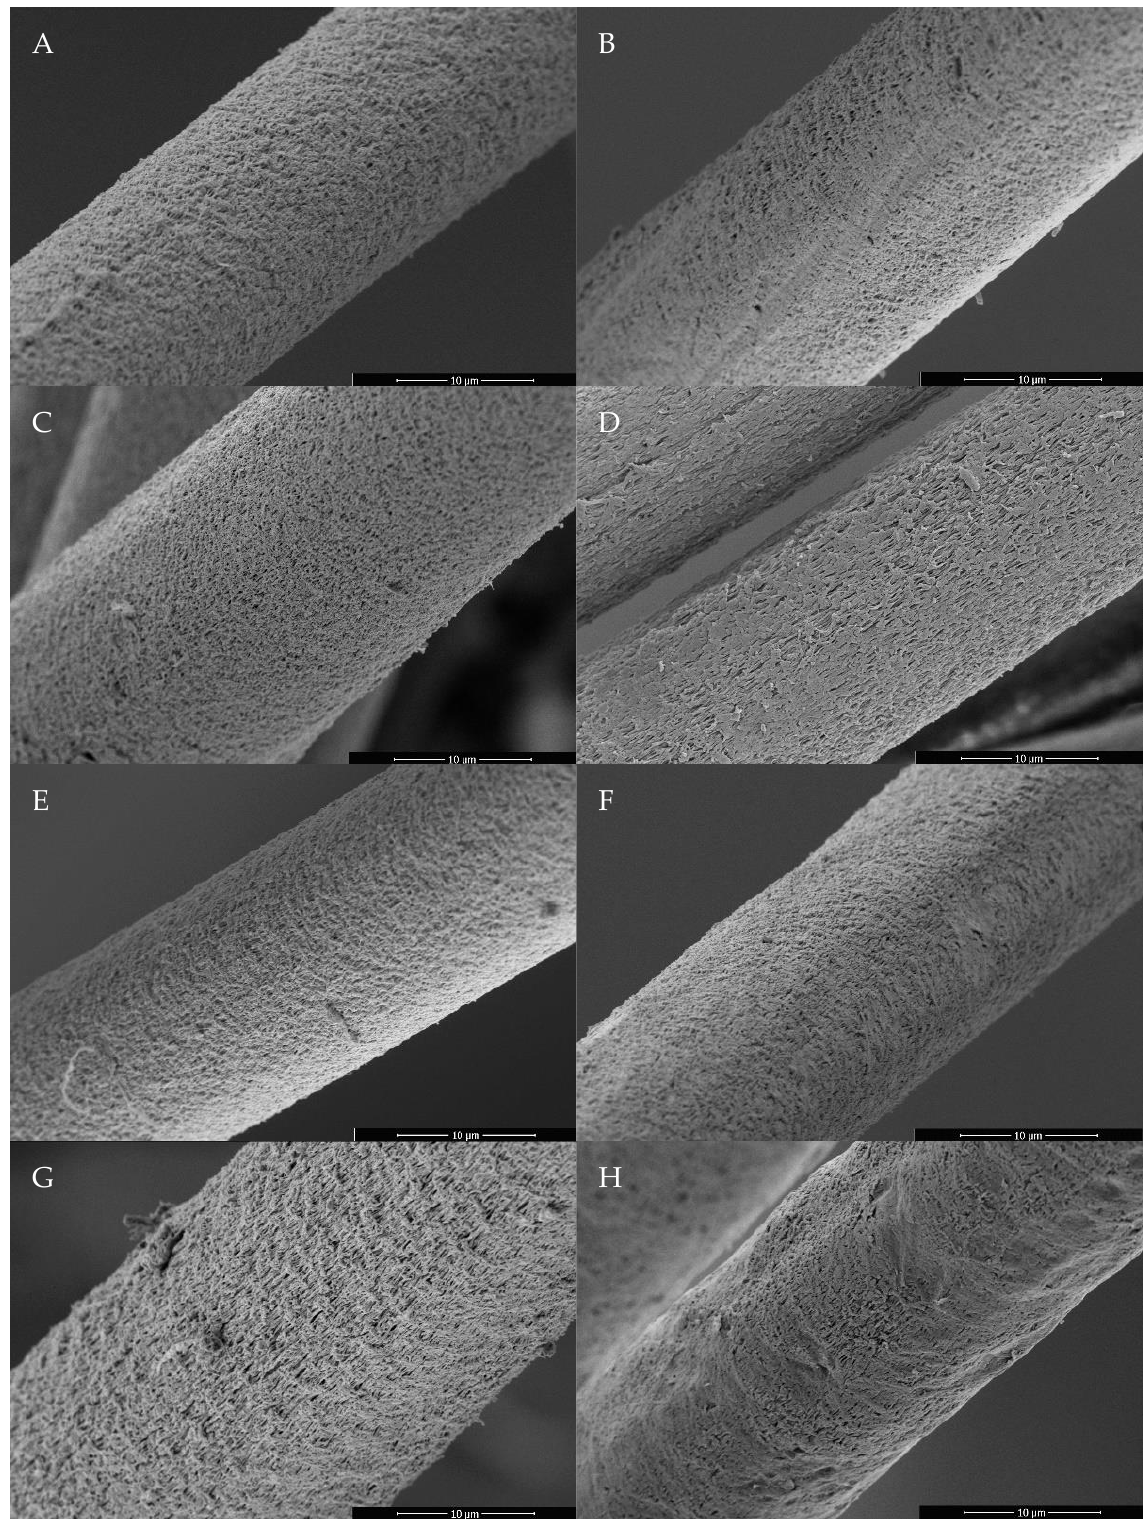
Figure 4. SEM images of the surface of the developed porous PAN/NC fibers after 50% stretching (left): ( A ) 0 wt.% NC, ( C ) 0.1 wt.% NC 1, ( E ) 0.4 wt.% NC 4 and ( G ) 0.8 wt.% NC; 100% stretching (right): ( B ) 0 wt.% NC, ( D ) 0.1 wt.% NC 1, ( F ) 0.4 wt.% NC 4 and ( H ) 0.8 wt.% NC.